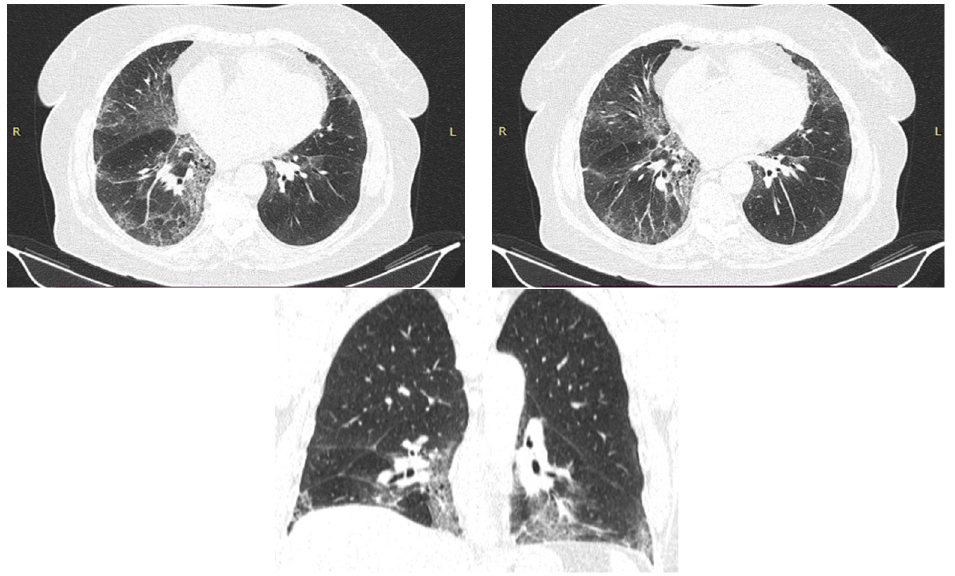
Figure 7. HRCT—2022—Case 3. Extensive areas of pulmonary condensation with ground glass. Bronchiectatic dilations.